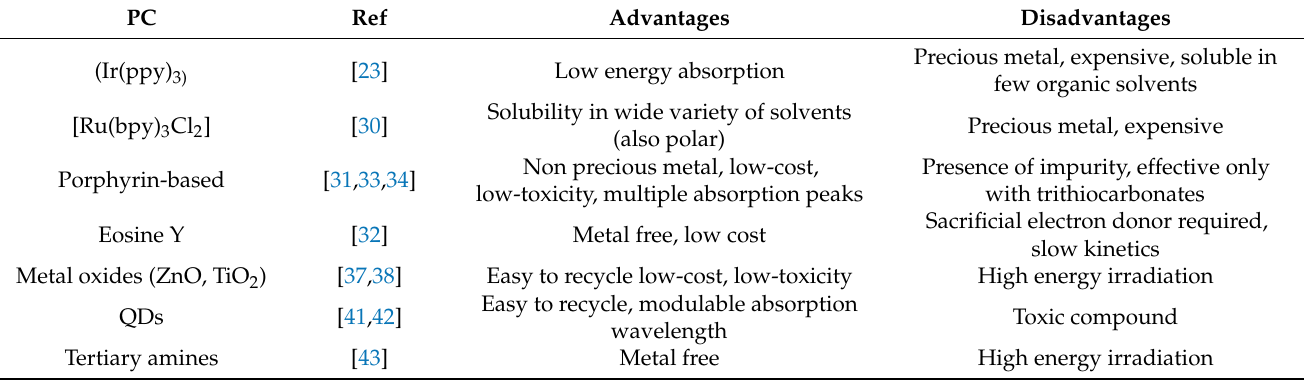
Table 1. Main advantaged and disadvantages of the most representatives photoredox